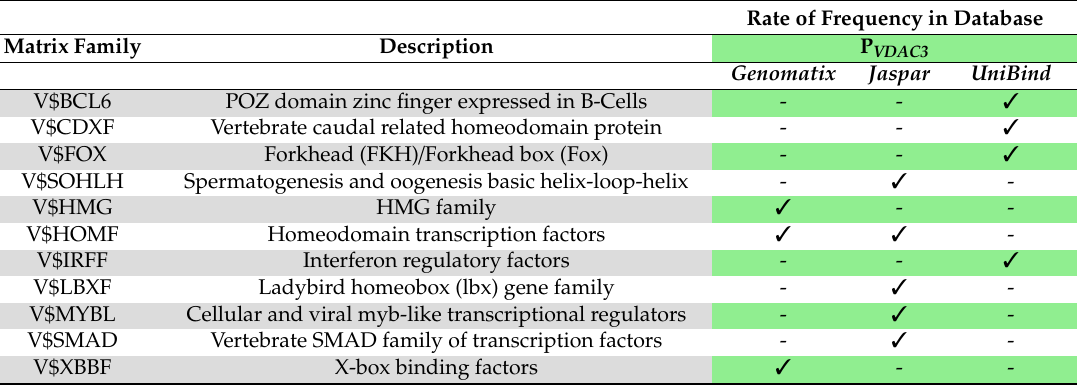
Table 4. VDAC3 unique Transcription Factor Binding Sites (TFBSs). The sign (cid:51) indicates the presence of the TFBS in P VDAC3 sequence selected by a specific